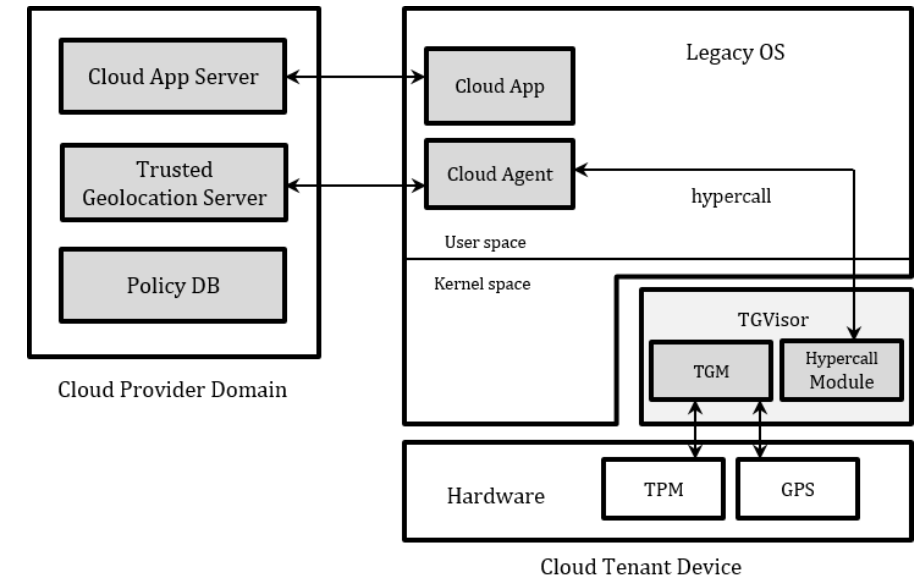
Figure 2. An Architecture of TGVisor